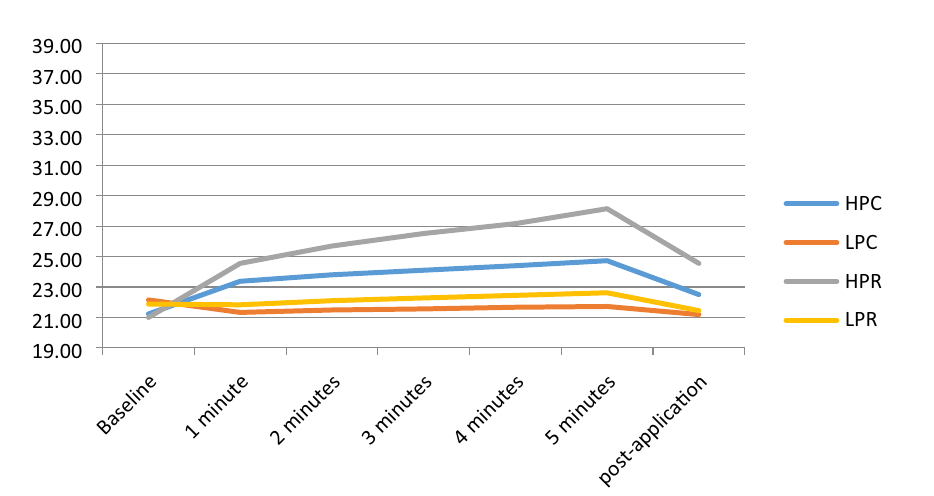
Figure 3. Intra-articular temperature. HPC high-power capacitive, LPC low-power capacitive, HPR high- power resistive, LPR low-power